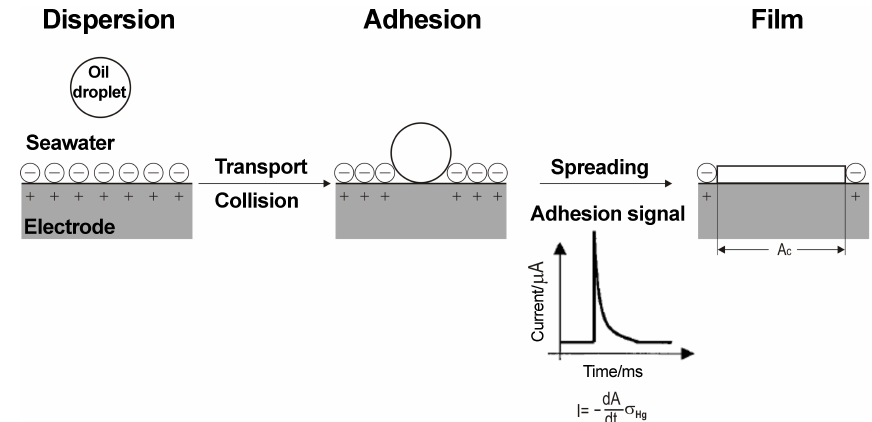
Figure 3. Basic principle of electrochemical adhesion-based detection: interaction of oil droplet with the charged electrode interface (adopted from Svetliˇci´c et al., 2001).